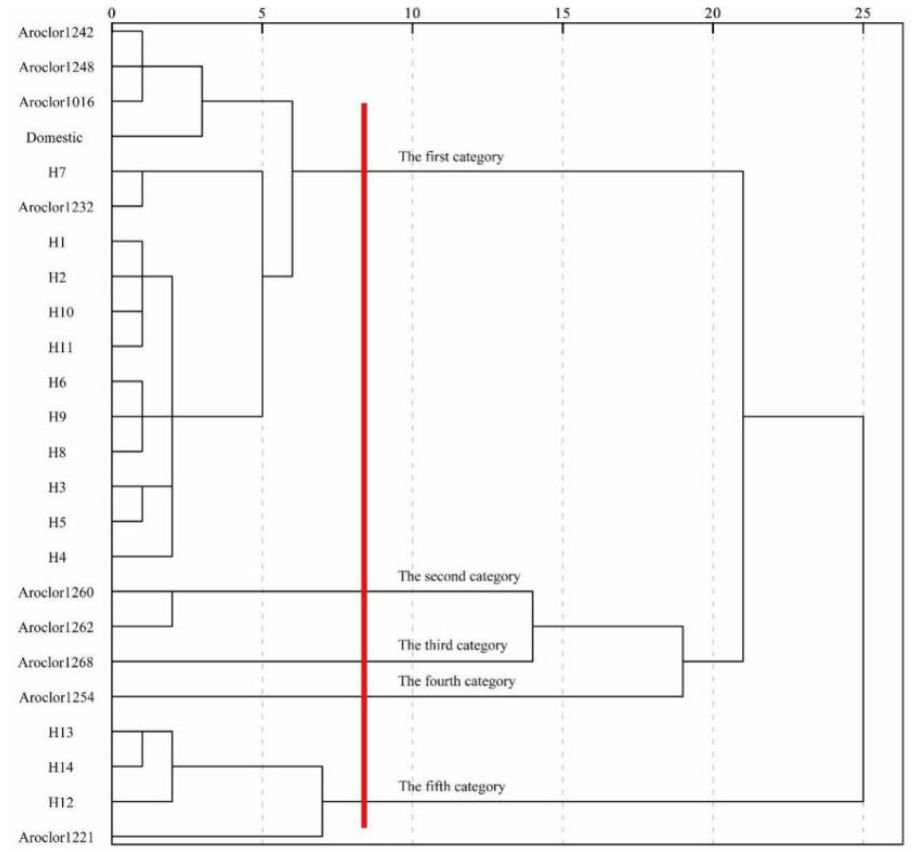
Figure 4. Hierarchial dendogram for soil samples in Hetao irrigation area, Aroclor PCBs and Chinese transformer